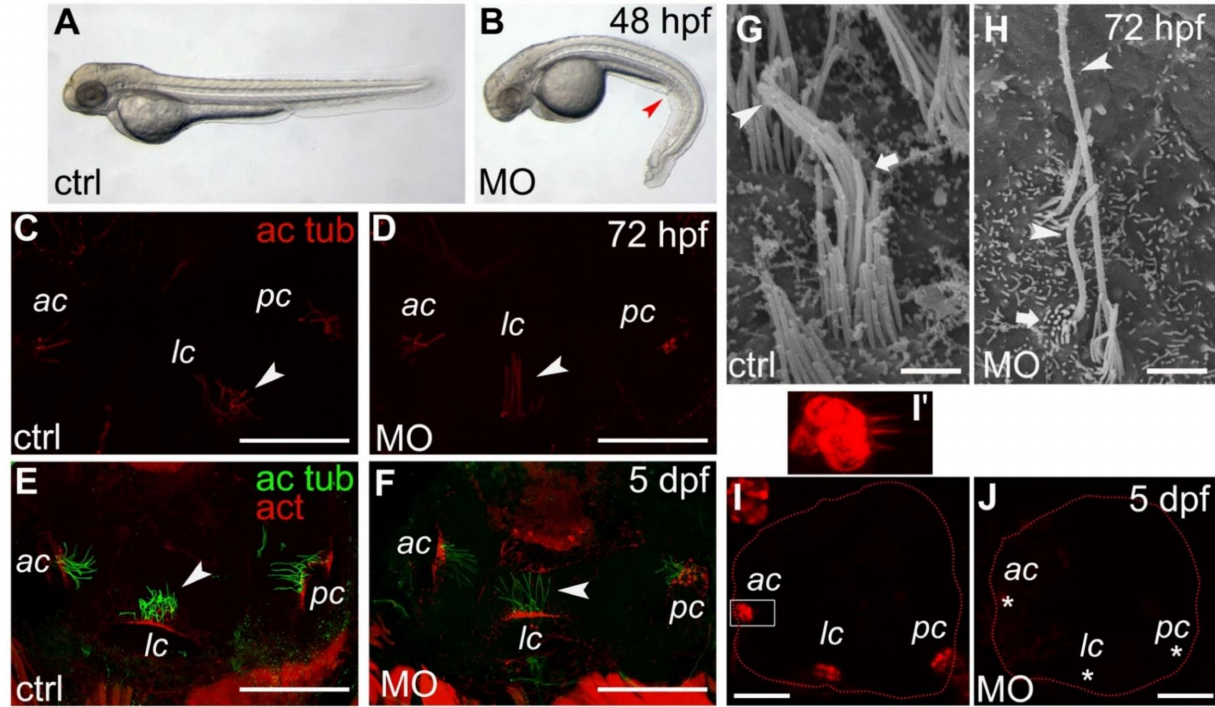
Figure 1. Phenotypical and ear defects in smpx zebrafish morphants (MO). ( A , B ) representative phenotype caused by the lack of Smpx. Control-MO ( A ) and smpx-MO ( B ) injected embryos. The red arrow points to the downward trunk/tail curvature indicative of cilia disfunction. ( C – F ) kinocilia of the anterior (ac), lateral (lc) and posterior (pc) cristae of the inner ear of 72 hpf ( C , D ) and 5 dpf ( E , F ) larvae injected with ctrl- ( C , E ) and smpx-MO ( D , F ). Cristae kinocilia are stained with the antibody against acetylated tubulin (ac tub); phalloidin is used to label the actin (act) of the stereocilia. White arrowheads indicate the different ‘posture’ of the lateral crista kinocilia. ( G , H ) SEM images of the ciliary bundle in the control larvae ( G ) and smpx morphants ( H ). The arrowhead indicates the kinocilium, with the arrow the stereocilia. ( I , J ) representative confocal images of the otic cavity injected with FM4-64, labeling the inner ear hair cells in the control larvae (( I ), n = 4) and smpx morphants (( J ), n = 7). The asterisks indicate the lack of signal in the ac, lc and pc of the Smpx-deficient larvae, suggestive of an impaired mechanotransduction. ( I’ ) magnified view of the anterior crista in ( I ) (white rectangle). Scale bars = 50 µ m in ( C – F ); 25 µ m in ( I , J ); 1 µ m in ( G , H